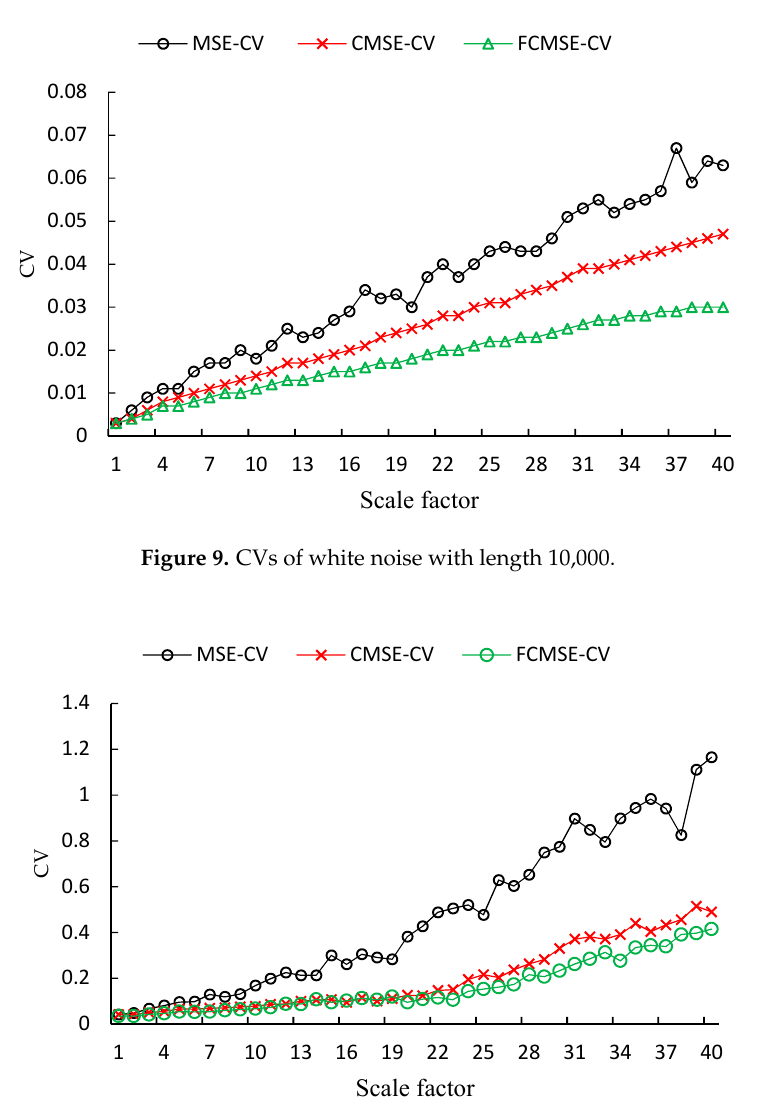
Figure 10. CVs of 1/f noise with length 1000.